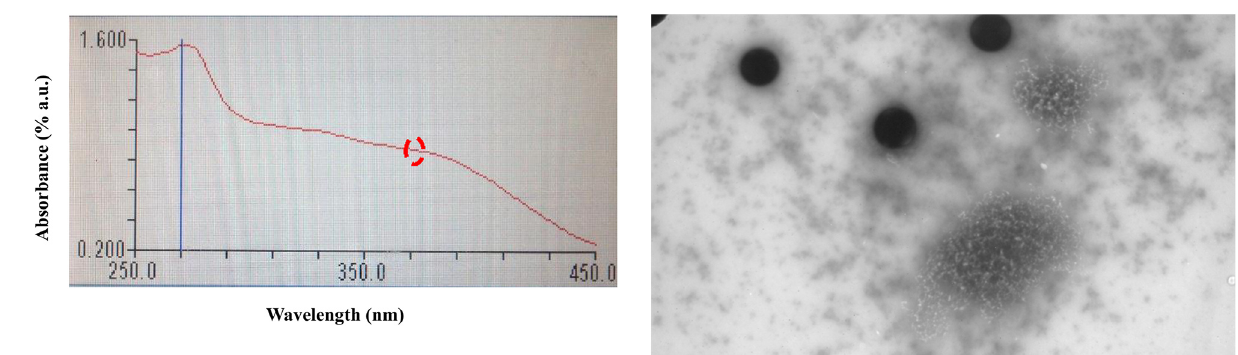
Figure 5: UV - Vis spectra of the mixture solution including Na 2 SeO 3 and walnut leaf extract after synthesis with exposure to microwave irradiation under the obtained optimum synthesis conditions.